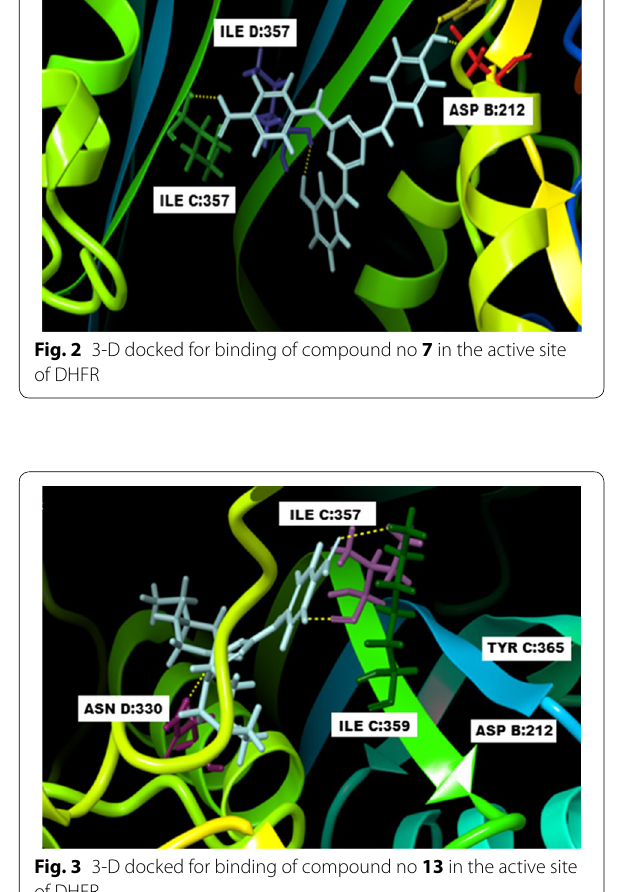
sandwiched –NH– group with ILE357 and between one of ring nitrogen atoms of triazine ring and ASN330 of the receptor. While the two dimensional interaction map (Additional file 1: Figure S2a) indicated that compound 18 maintained hydrophobic interactions with seven interacting residues in the binding site. Besides, NH + group of piperazine ring formed charged transition with ASP334. Similarly, one of the charged oxygen atom of nitro group formed salt bridge with LYS359.